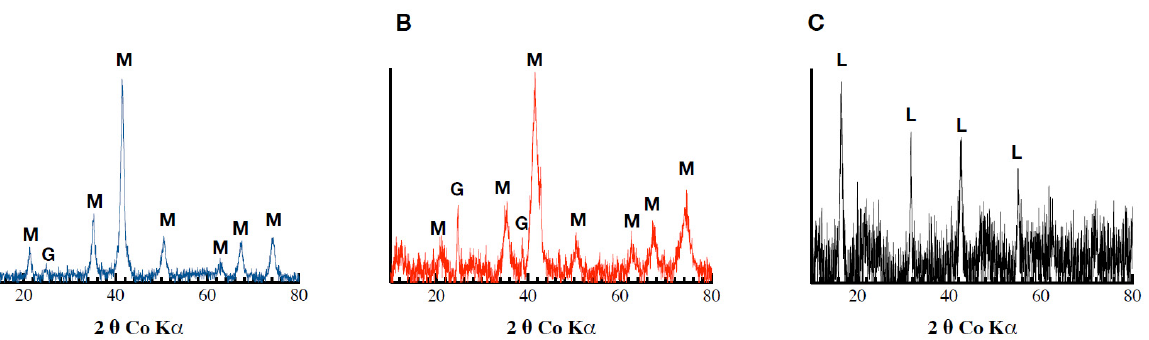
Figure 4. Diffractograms obtained following Co-XRD measurements of the ( A ) Fh, ( B ) Fh_Pb(0.02), and ( C ) Fh_Pb(0.05) systems after the RP2 with Shewanella oneidensis MR-1.